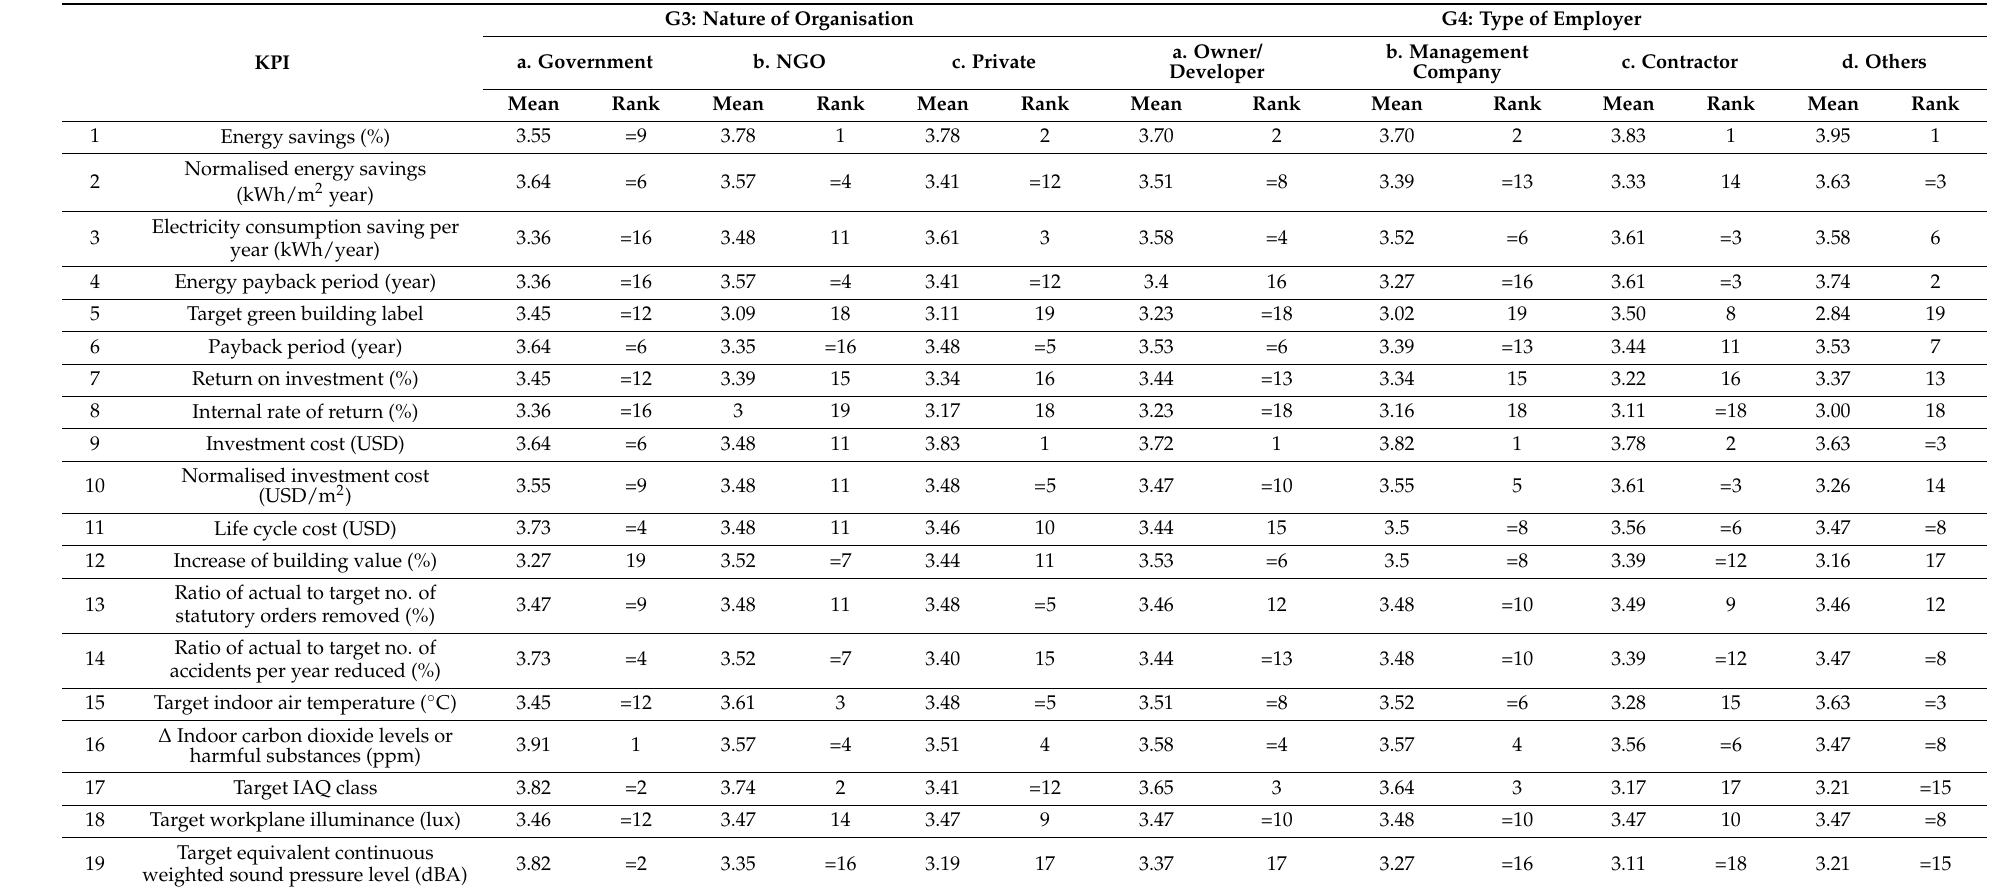
Table A2. Mean importance ratings and ranks of KPIs (G3 and